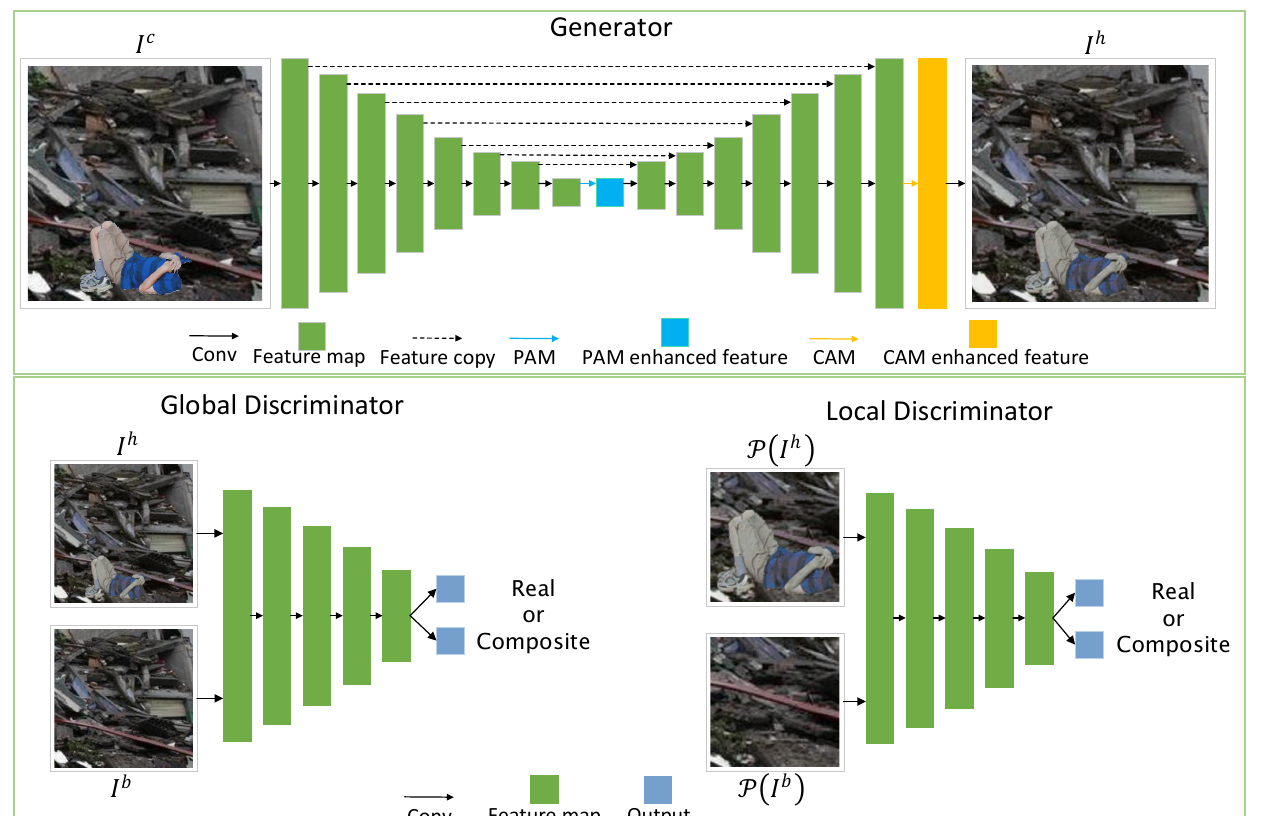
Figure 3. Our framework has a generator G and two five-layers discriminators D global and D local . The generator takes a composite image I c as input, and generates a harmonious image I h . Two discriminators discriminate the real images and the generated harmonious images globally and locally,